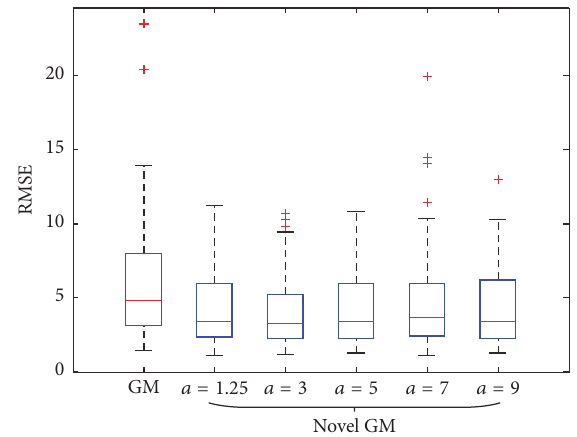
Figure 8: Box plot of RMSEs at different values of 𝑎 in the novel GM and